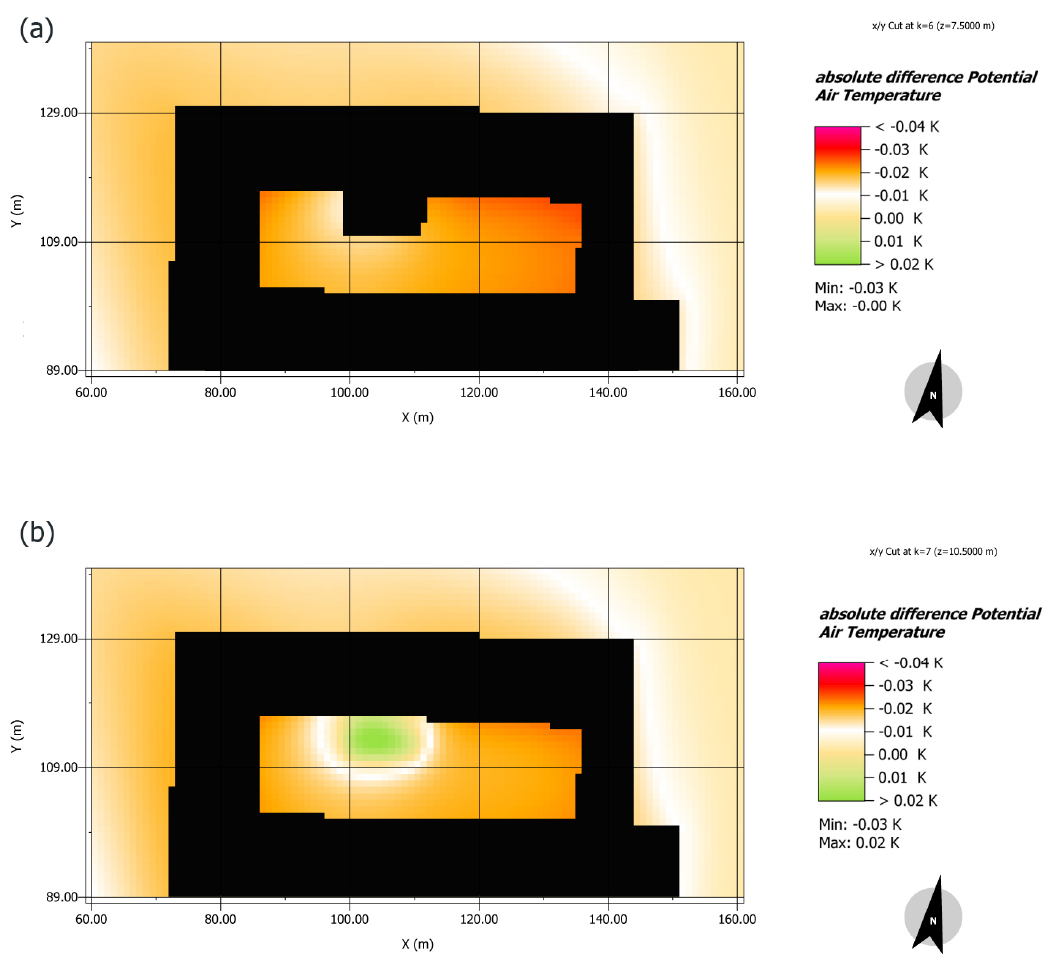
Figure 15. The initial state and green roof air temperature difference comparison in horizontal cross sections at the height of 7.5 m (a) and 10.5 m (b). Figure by authors.